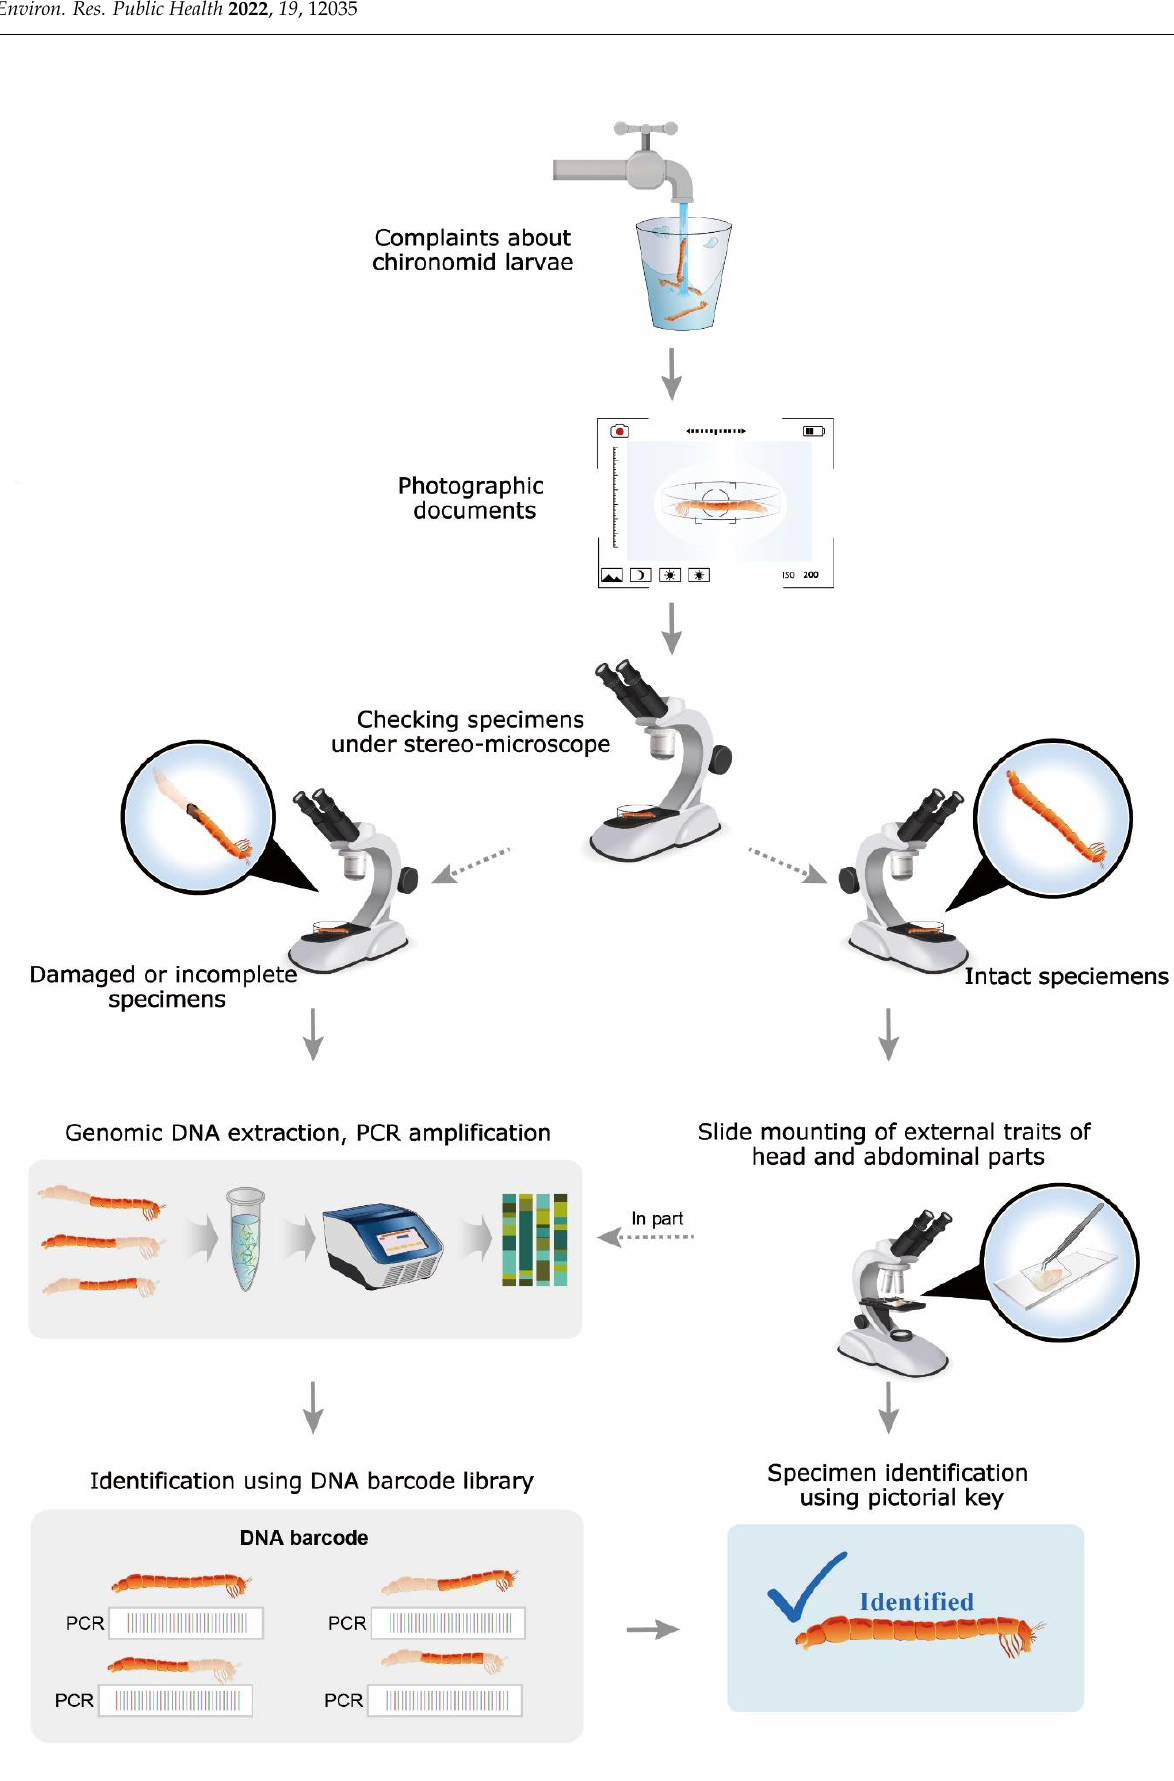
Figure 4. Action protocol for rapid identification of chironomid larvae to respond to environmental issues .